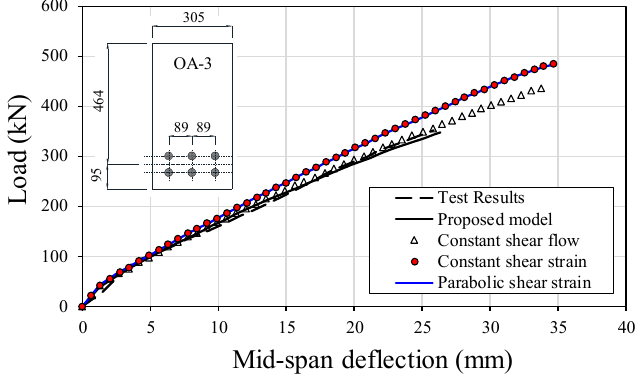
Figure 10. Applied load versus mid-span deflection (OA-3 specimen).